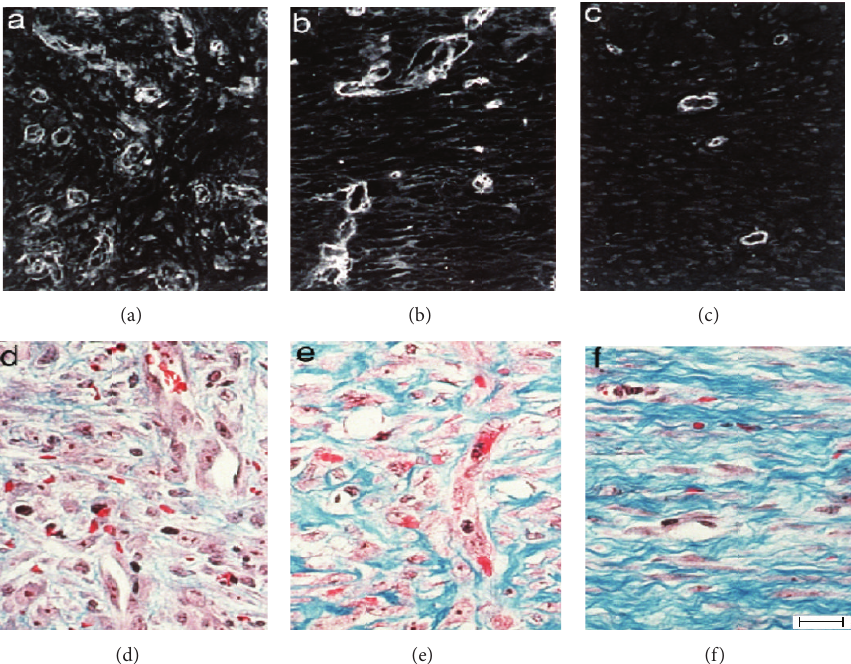
Figure 2: Angiogenic blood vessels in early granulation tissue mature and then regress as wound repair progresses. Porcine wounds at 5 days (a, d), 7 days (b, e), and 10 days (c, f) were stained with Masson trichrome (d, e, f) and antibody to laminin (a, b, c). At 5 days (a, d), the wound space is almost filled with granulation tissue, rich in newly forming microvessels. At 7 days (b, e), the neoepidermis has completely formed, the granulation tissue has organized, and the neovessels have matured and assumed a vertical orientation. At 10 days (c, f), wound contraction is underway, and blood vessel regression is apparent. Bar = 80 micron in (a, b, c) and 50 micron in (d, e,